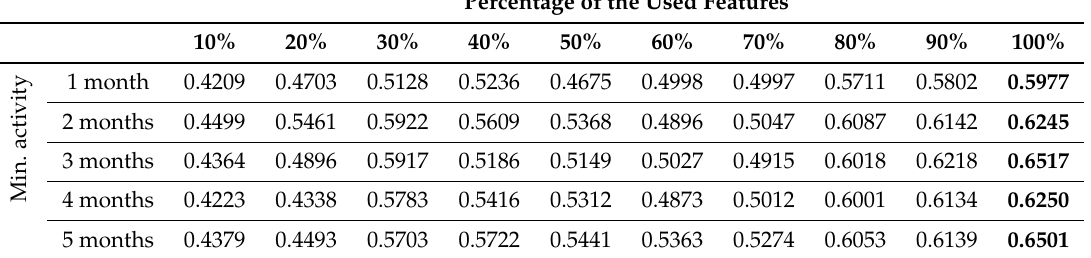
Table A4. F-score macro average for the SVM classification of two levels of the hierarchy in the manufacturing company dataset. The values which are bolded are the best results for a given minimum communication activity.